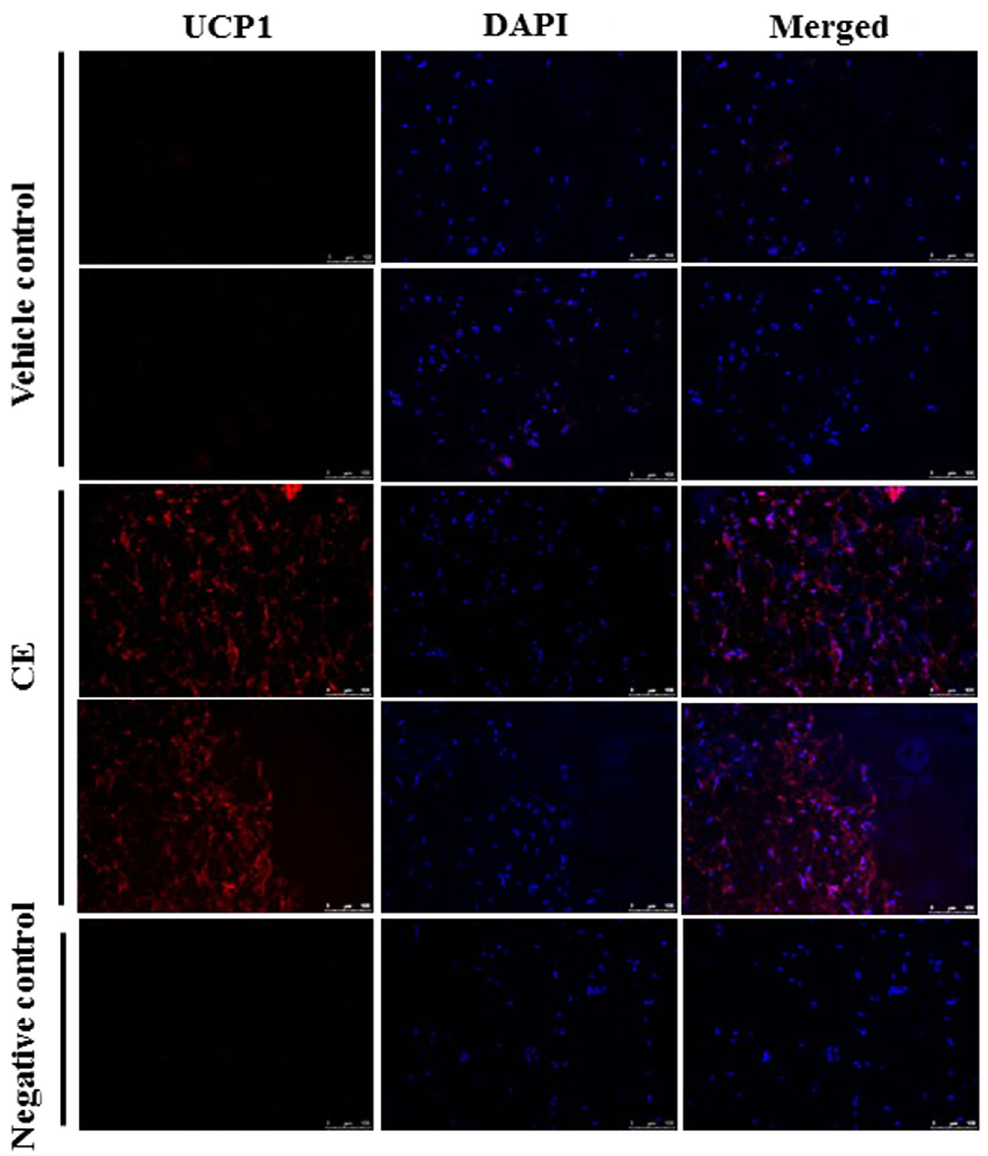
Figure 9. Immunostaining of UCP1 (left panel) and DAPI (4 ′ ,6-diamidino-2-phenylindole staining) (middle panel) in the subcutaneous tissues isolated from vehicle control and CE-treated DIO mice. Merged images are shown in the right panel. CE, cinnamon extract (500 mg/kg body weight). UCP1, uncoupling protein 1. Original magnification